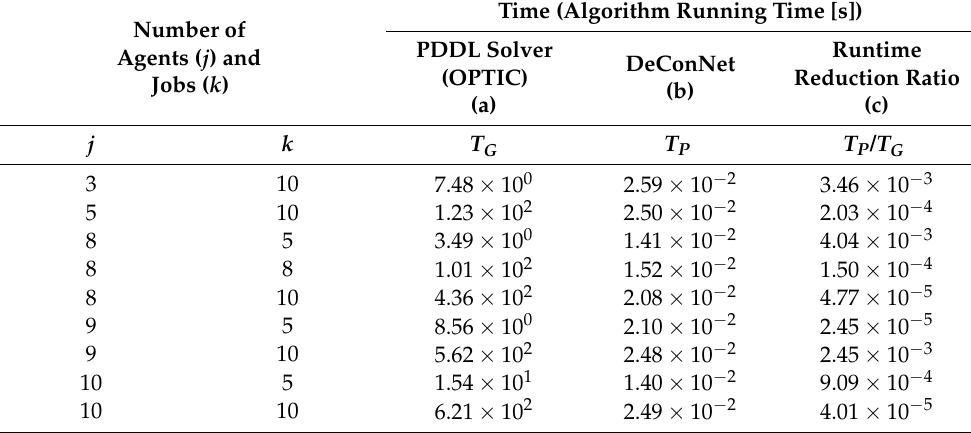
Table 5. Comparison of the execution time [s] of the ground cost to the prediction time of the